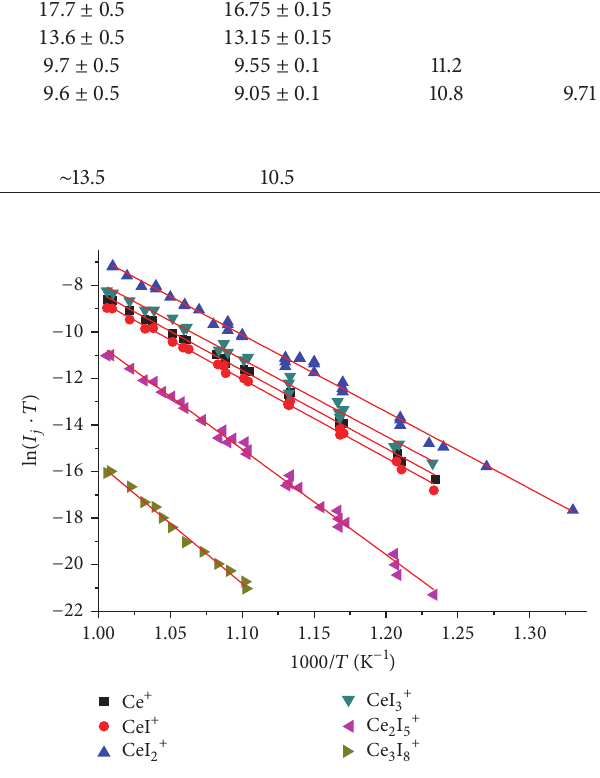
Figure 4: Temperature dependence of ion currents in the EI